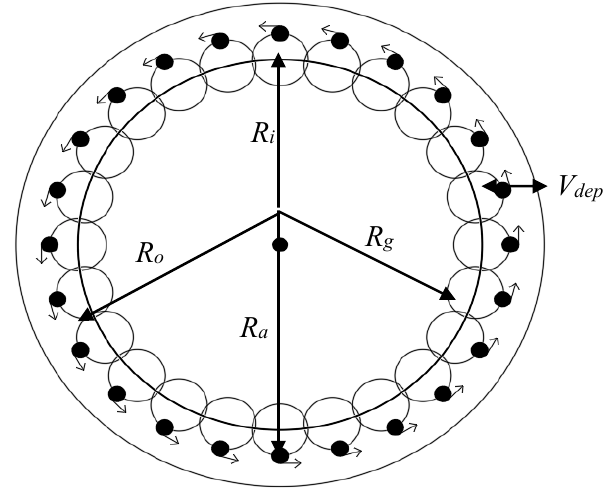
Figure 3. Schematic view of the electron beam cross-section at an arbitrary axial position.